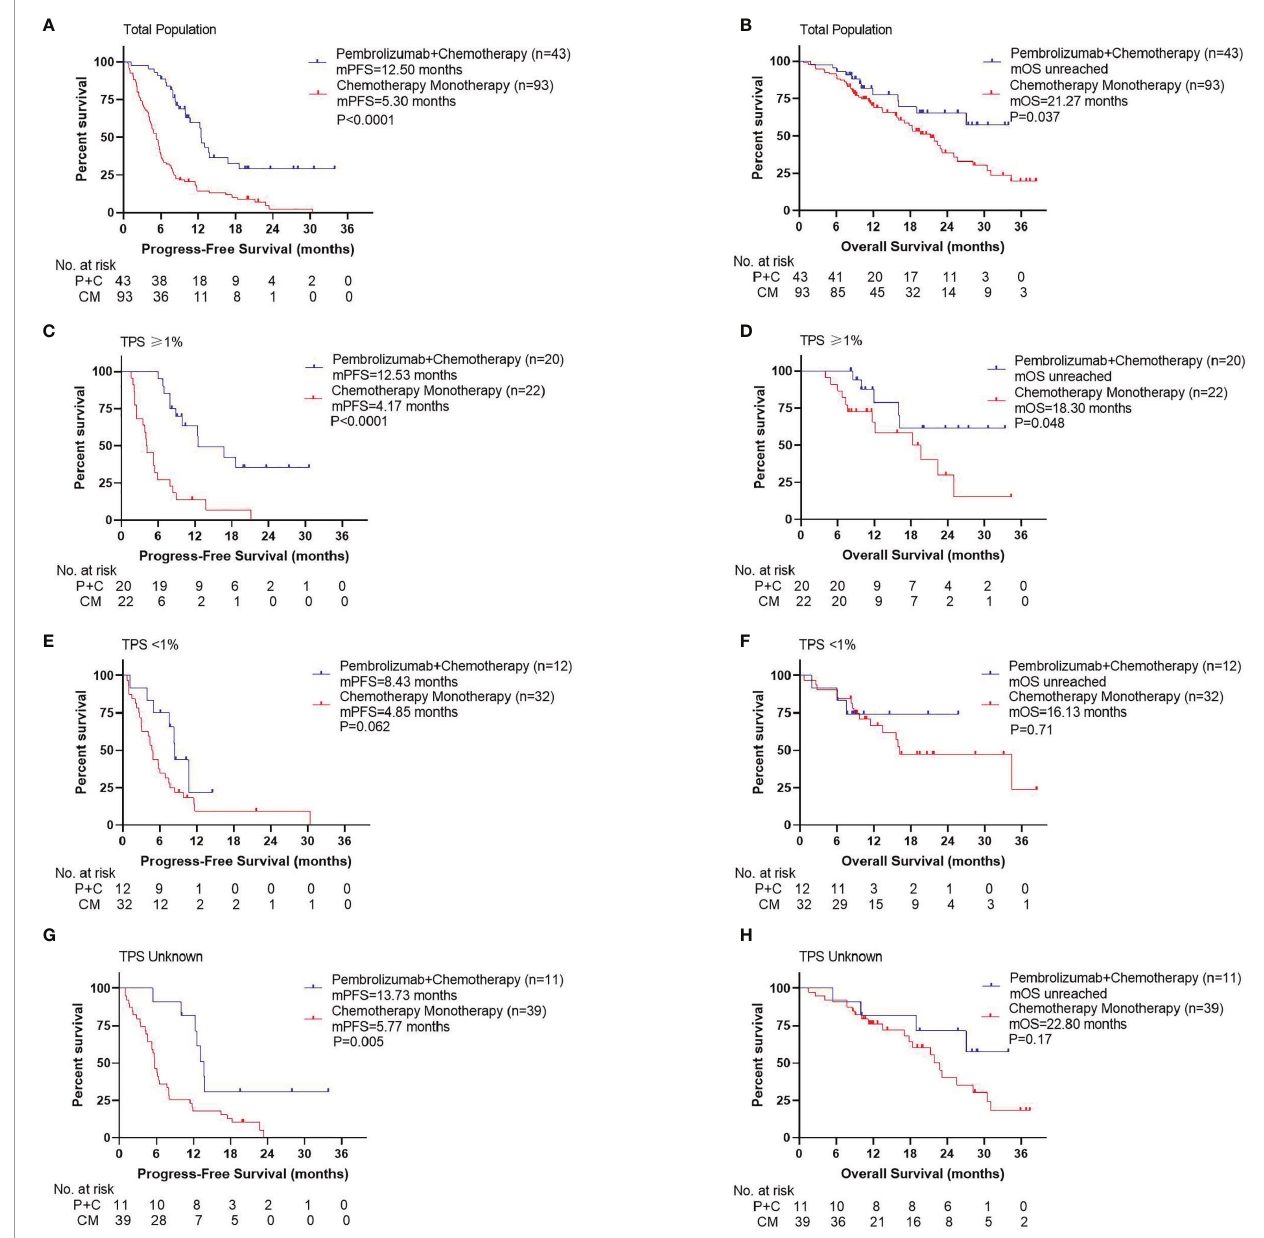
FIGURE 2 | Survival curves for different treatments. (A) Progression-free survival, (B) Overall survival by treatments of total population. (C) Progression -free survival, (D) Overallsurvival bytreatments of patients with TPS ≥ 1%. (E) Progression -free survival, (F) Overallsurvival bytreatments ofpatients with TPS <1%. (G) Progression -free survival, (H) Overallsurvival bytreatments of patients with TPS